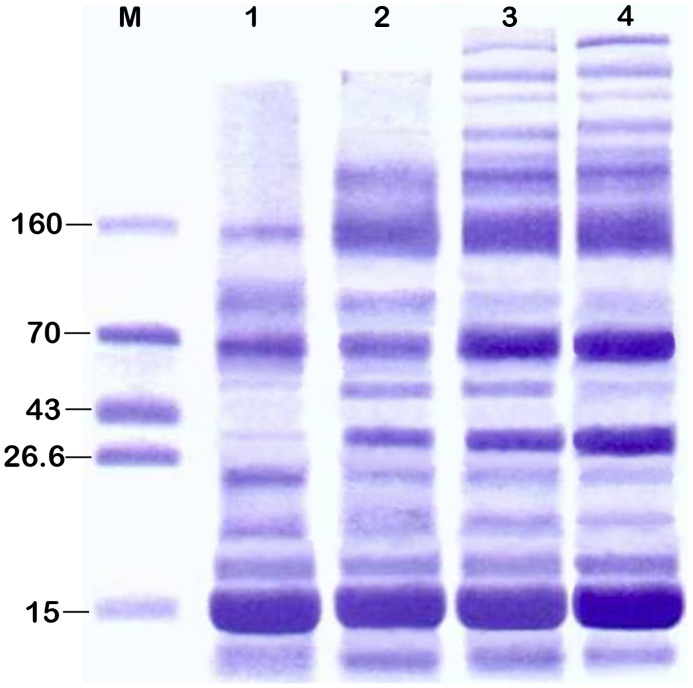
SDS-PAGE analysis of urinary proteins of the rats after exposure to GDF.Lane 1–4 represents urine sample at 8, 10, 11 and 12 weeks, respectively. M. Protein standard (kD).